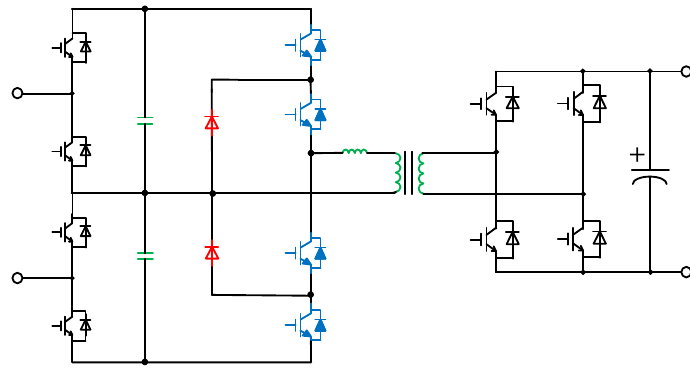
Figure 11. DCT for hybrid PV, ESS, and various industrial load access scenarios .